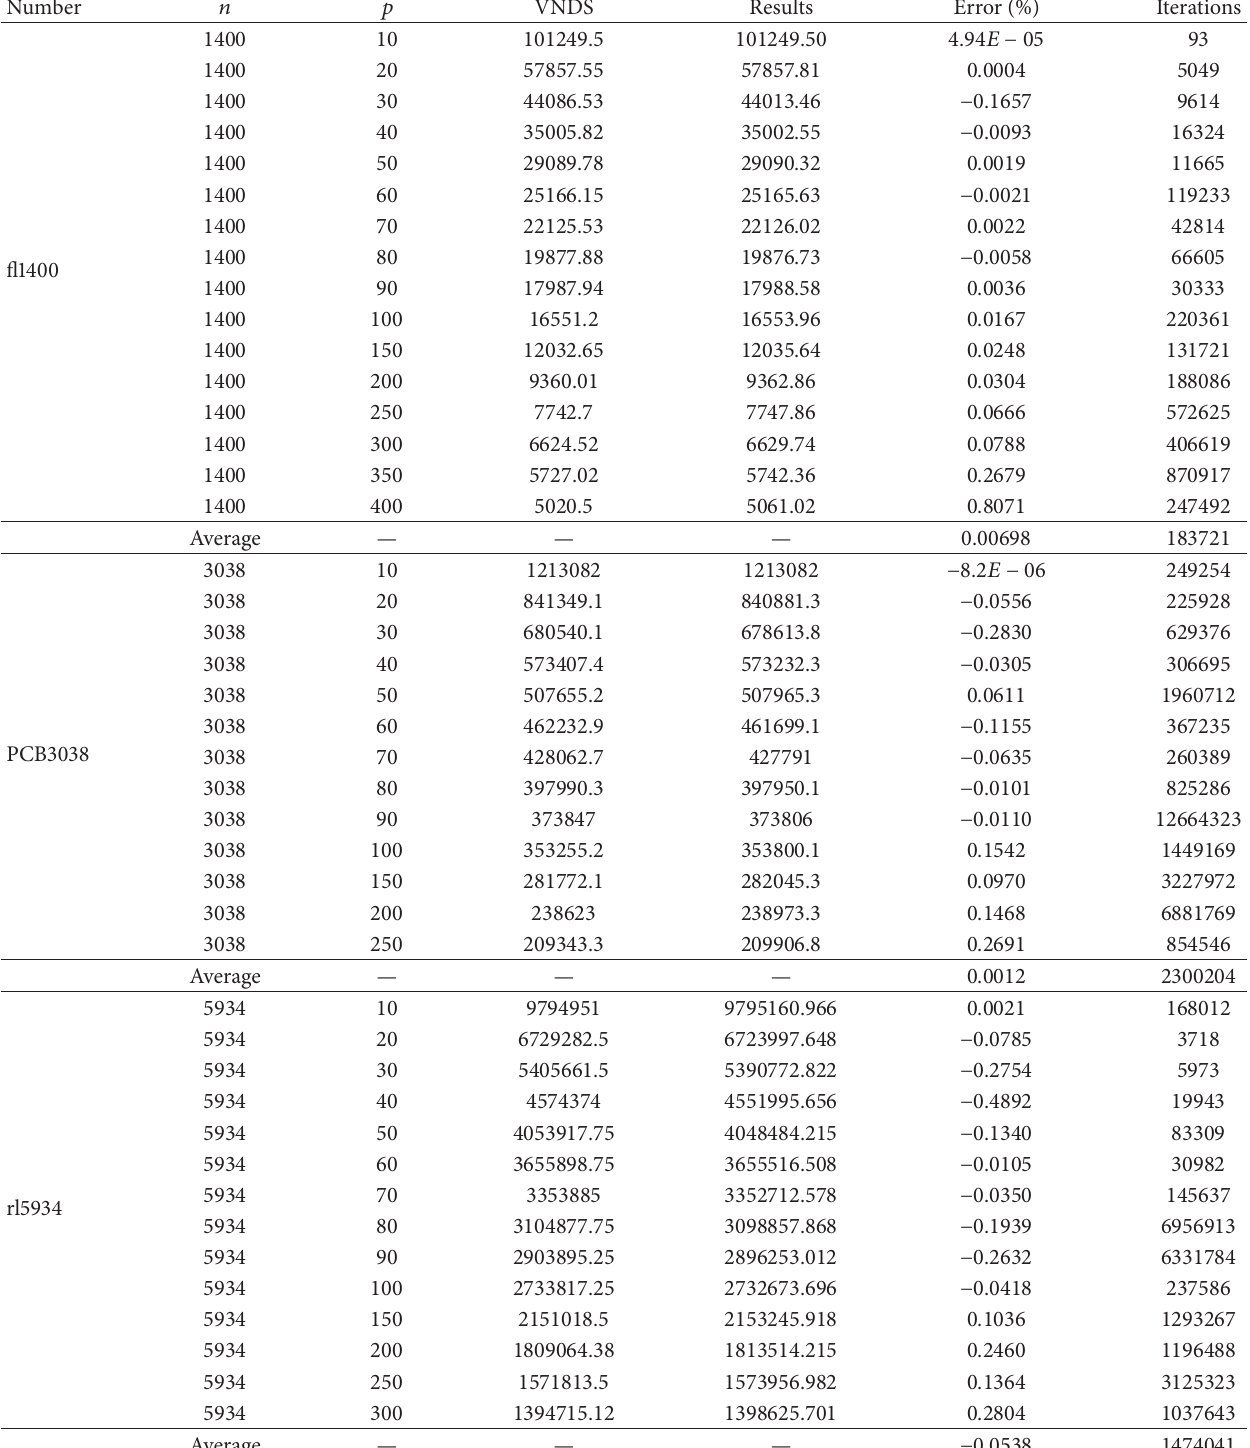
Table 2: The computational results for the fl1400 and pcb3038 instances.